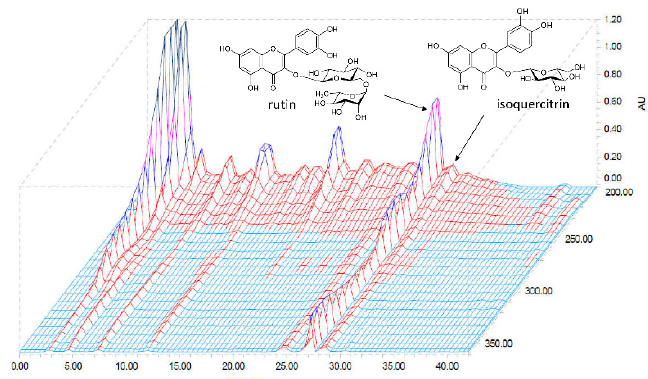
Figure 1. Three-dimensional HPLC chromatogram of Annona atemoya leaf (AAL) ethanol extract.